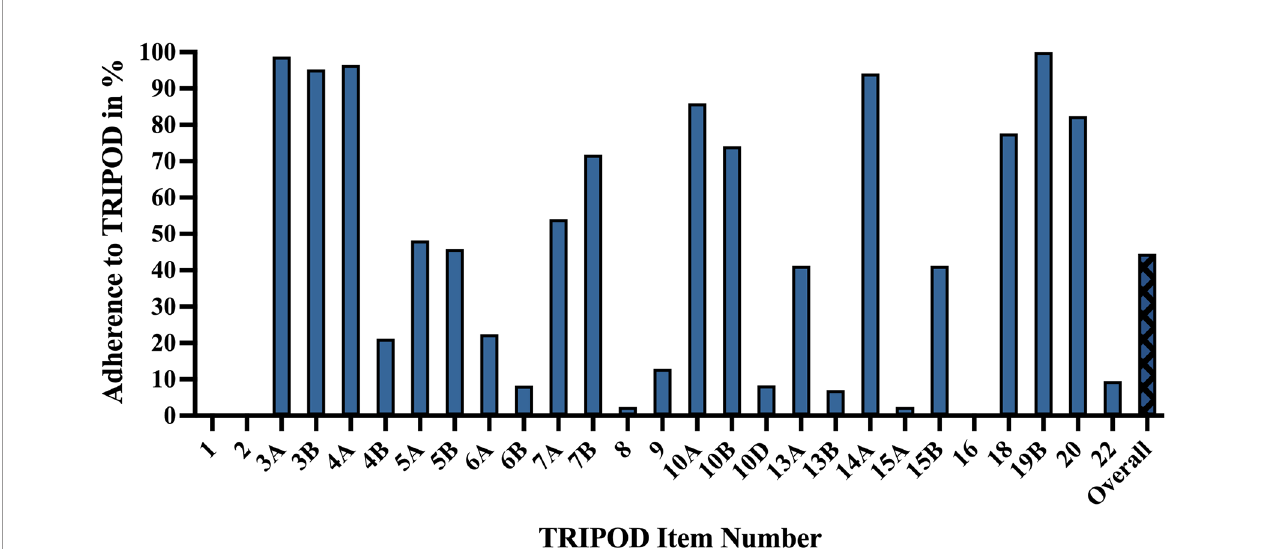
FIGURE 6 | TRIPOD adherence of machine learning glioma grade prediction studies. Adherence rate for individual items represents the percent of studies scoring a point for that item: 1 – title. 2 – abstract. 3a – background. 3b – objectives. 4a – study design. 4b – study dates. 5a – study setting. 5b – eligibility criteria. 6a – outcome assessment. 6b – blinding assessment of outcome. 7a – predictor assessment. 7b – blinding assessment of predictors. 8 – sample size justi fi cation. 9 – missing data. 10a – predictor handling. 10b – model type, model-building, and internal validation. 10d – model performance. 13a – participant fl ow and outcomes. 13b – participant demographics and missing data. 14a – model development (participants and outcomes). 15a – full model speci fi cation. 15b – using the model. 16 – model performance. 18 – study limitations. 19b – results interpretation. 20 – clinical use and research implications. 22 – funding. Overall – mean TRIPOD adherence rate of all studies. TRIPOD, Transparent Reporting of a multivariable prediction model for Individual Prognosis Or